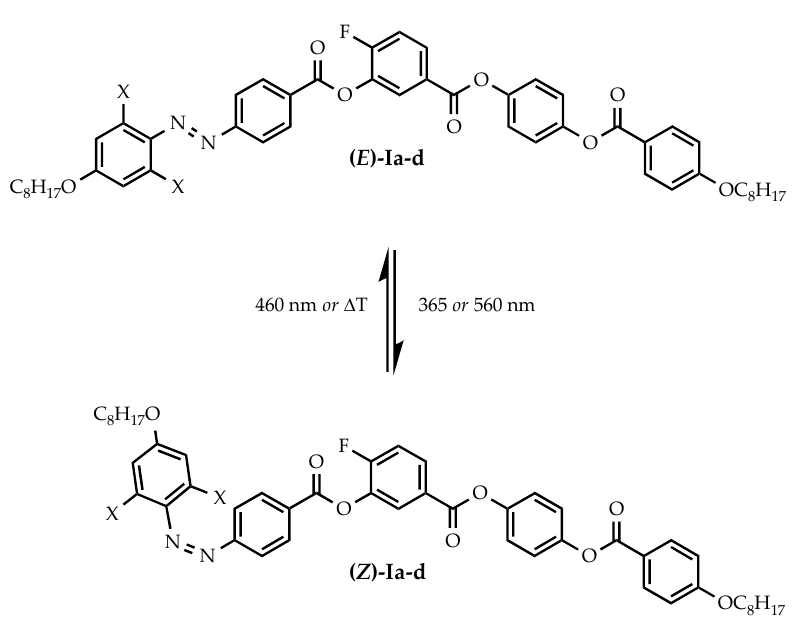
Figure 5. Photochemical isomerization of prepared BCLCs.